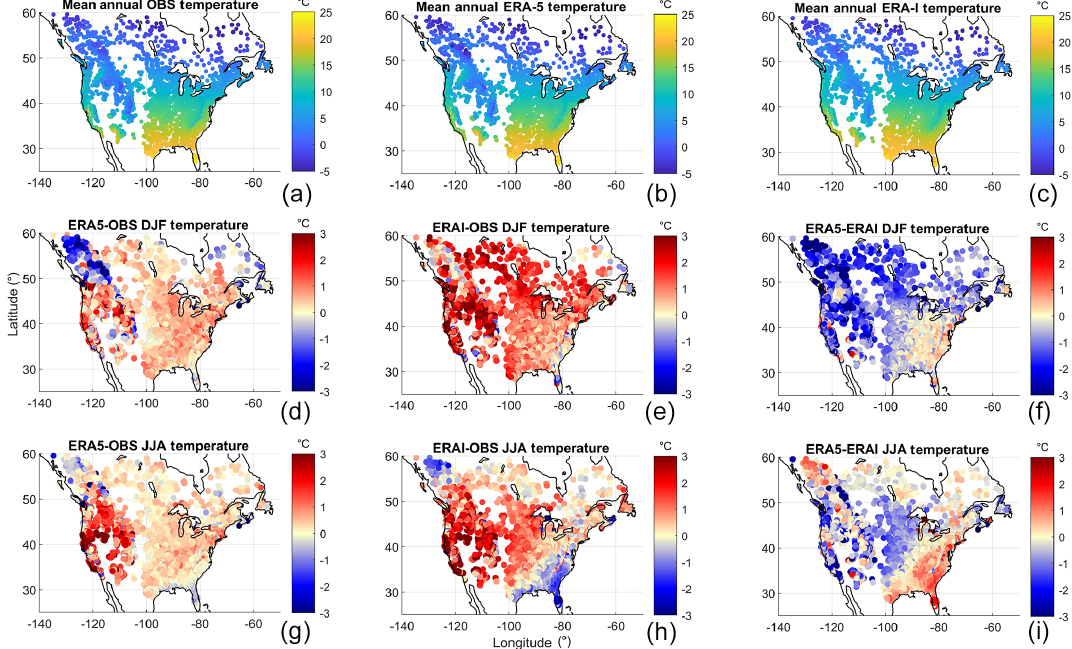
Figure 2. Mean annual temperature for all three datasets (a, b, c) and seasonal differences (winter in d, e, f , summer in g, h, i ). All values are in degrees